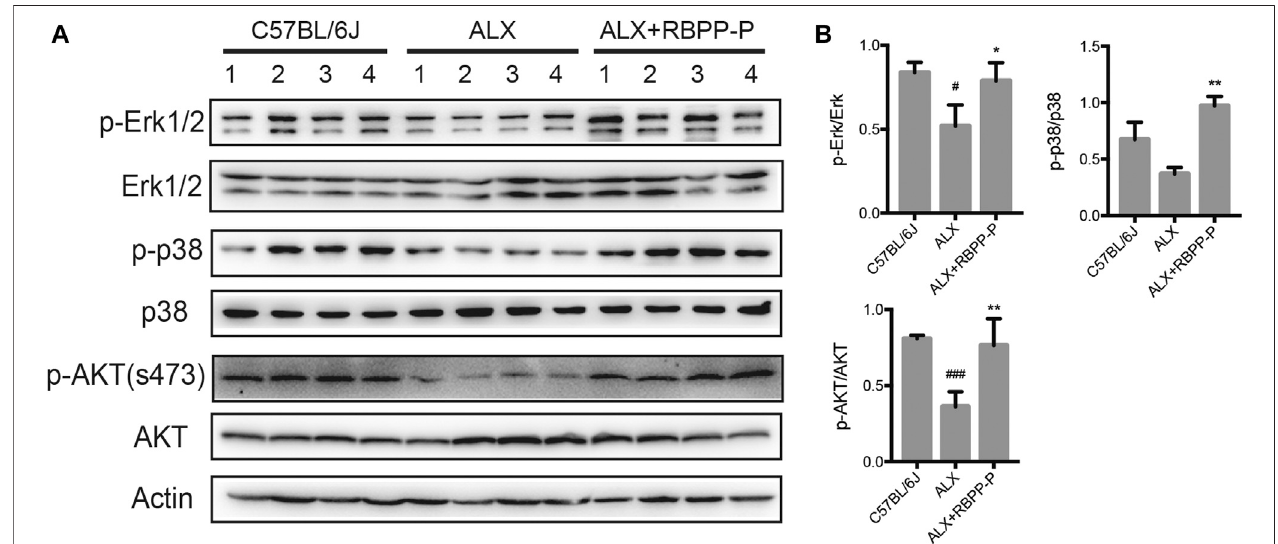
FIGURE 5 | The expression of AKT and MAPK signaling pathways in RBPP-P mice pancreas. (A) The MAPK and AKT signaling pathways were analyzed using western blotting (B) Band density was measured using the ImageJ. All data are expressed as mean ± s. d. # p < 0.05, ### p < 0.001, vs. C57BL/6J mice; *p < 0.05, **p < 0.01, vs. ALX